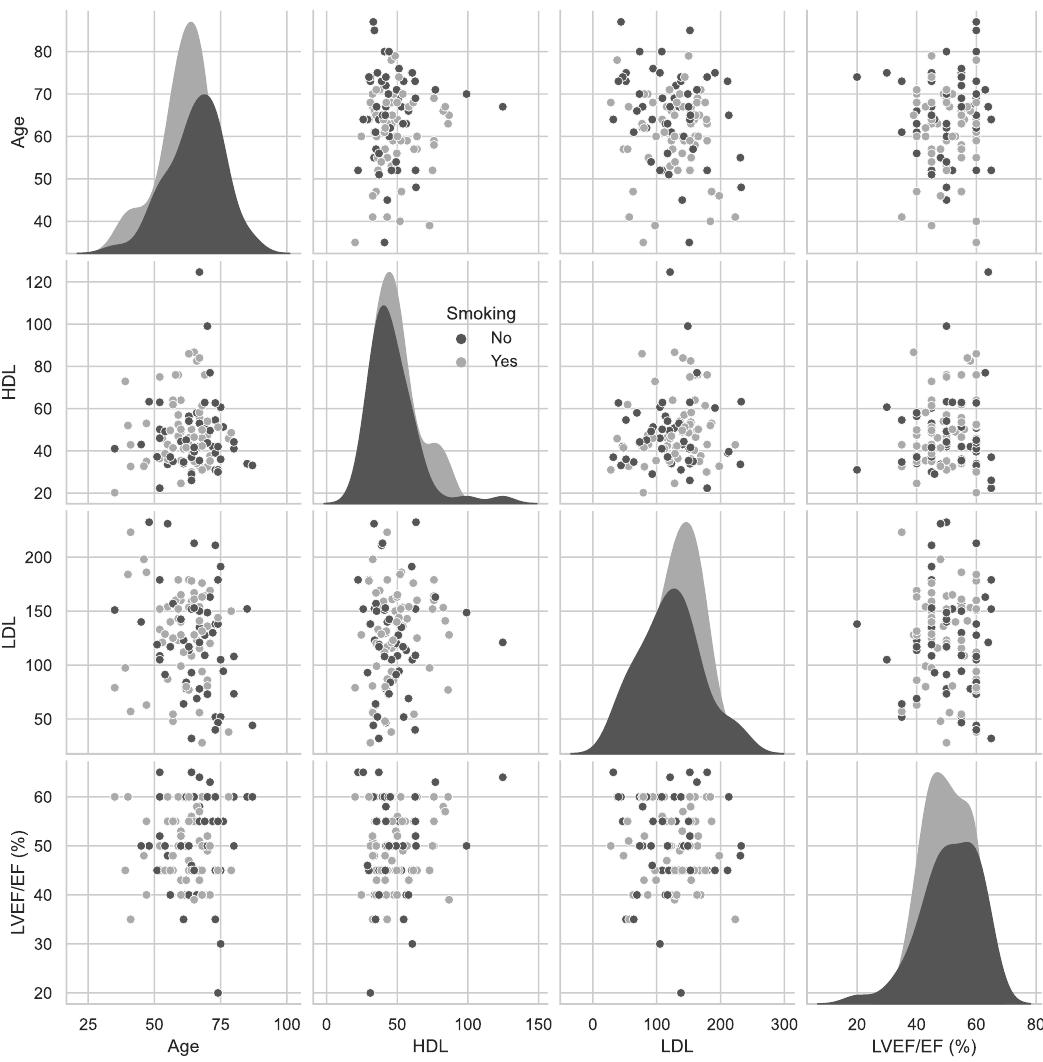
Figure 3. A pairwise relationship between variables age, HDL, LDL, and LVEF/EF.